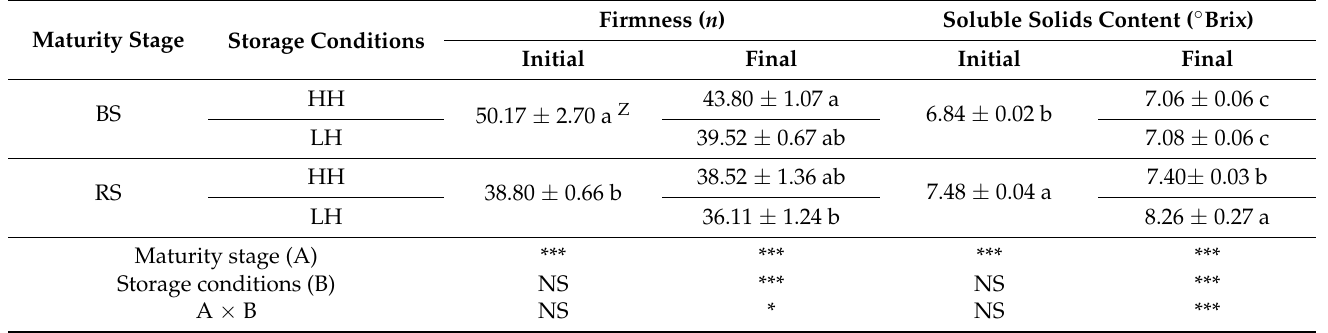
Table 1. The effect of high and low RH on the soluble solids content and firmness of sweet peppers before and after 15 days of cold storage at 5 ◦ C and 5 days at ambient